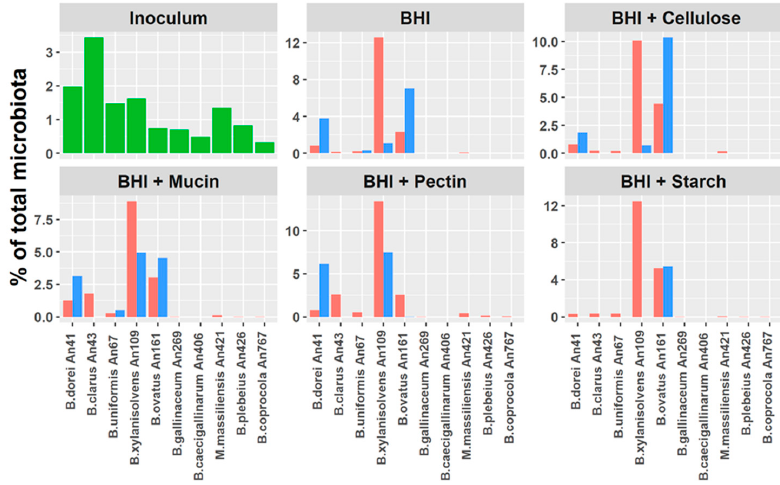
Figure 5. Real-time PCR quantification of Bacteroides species after co-culture in